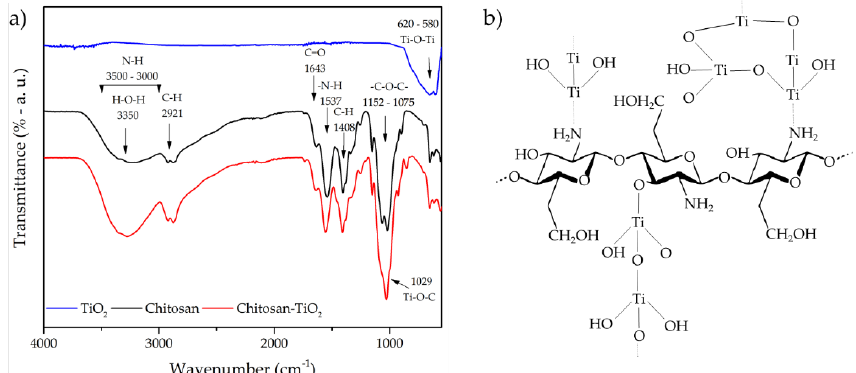
Figure 2. Fourier transform infrared spectra of TiO 2 , chitosan, and chitosan – TiO 2 hybrid composite ( a )